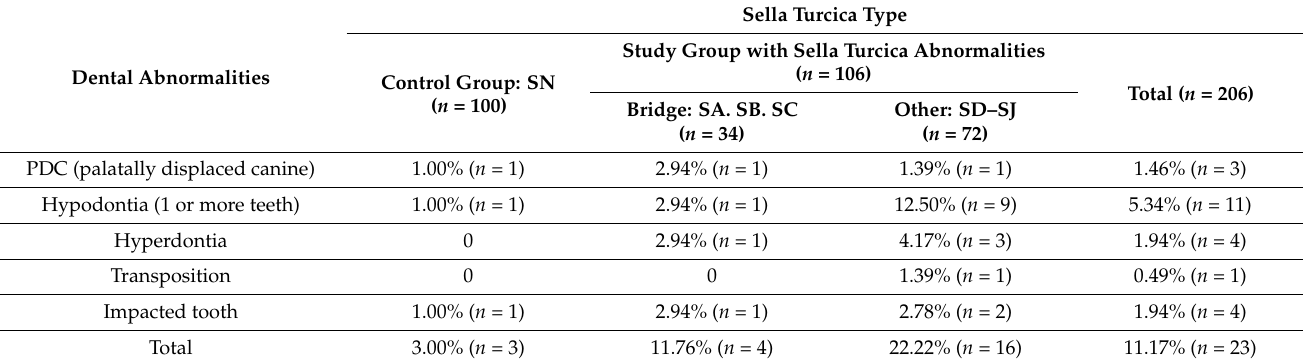
Table 3. Dental abnormalities in the study and control